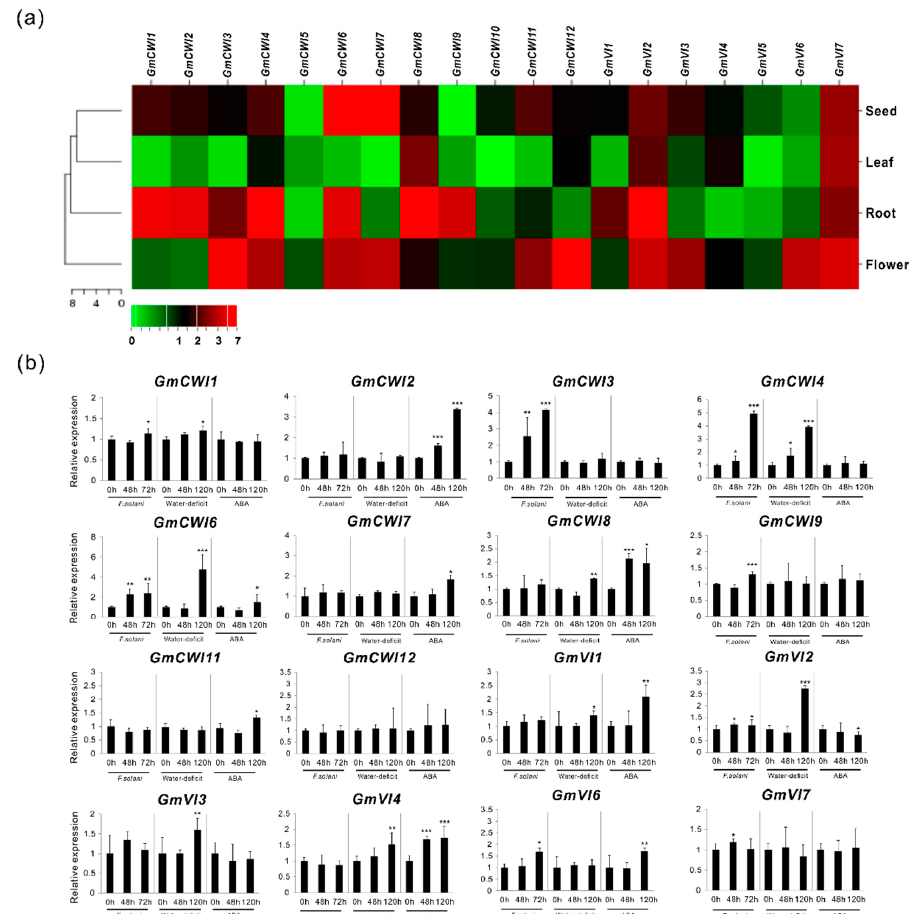
Figure 7. Expression validation of the acid invertase genes. Relative expressions in various tissues as well as in response to stress factors ( F. solani , Water-deficit, and ABA) were conducted by qRT-PCR ( a , b ). Data represent mean value of at least three independent biological replicates. GmACT2/7 , GmACTII , GmEF/ α b , and GmCYP were used as reference genes. Asterisks indicate significant differences in comparison with the control using Student’s t -test: p < 0.001 (***), p < 0.01 (**), p < 0.05 (*).